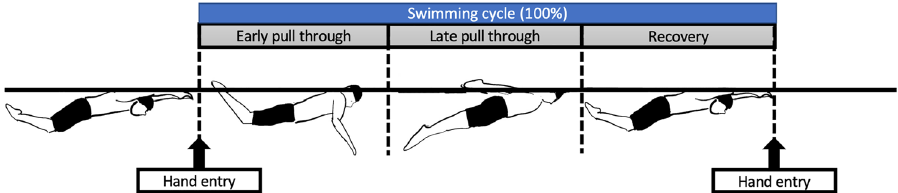
Figure 2. Definitions of the different phases of swimming cycles. (1) Early pull-through started at the beginning of hand entry into the water and ended when the humerus was perpendicular to the axis of the torso connecting the acromion and the greater trochanter. (2) Late pull-through began at the completion of early pull- through and ended as the hand left the water. (3) The recovery phase started at the beginning of the hand exit and ended at hand